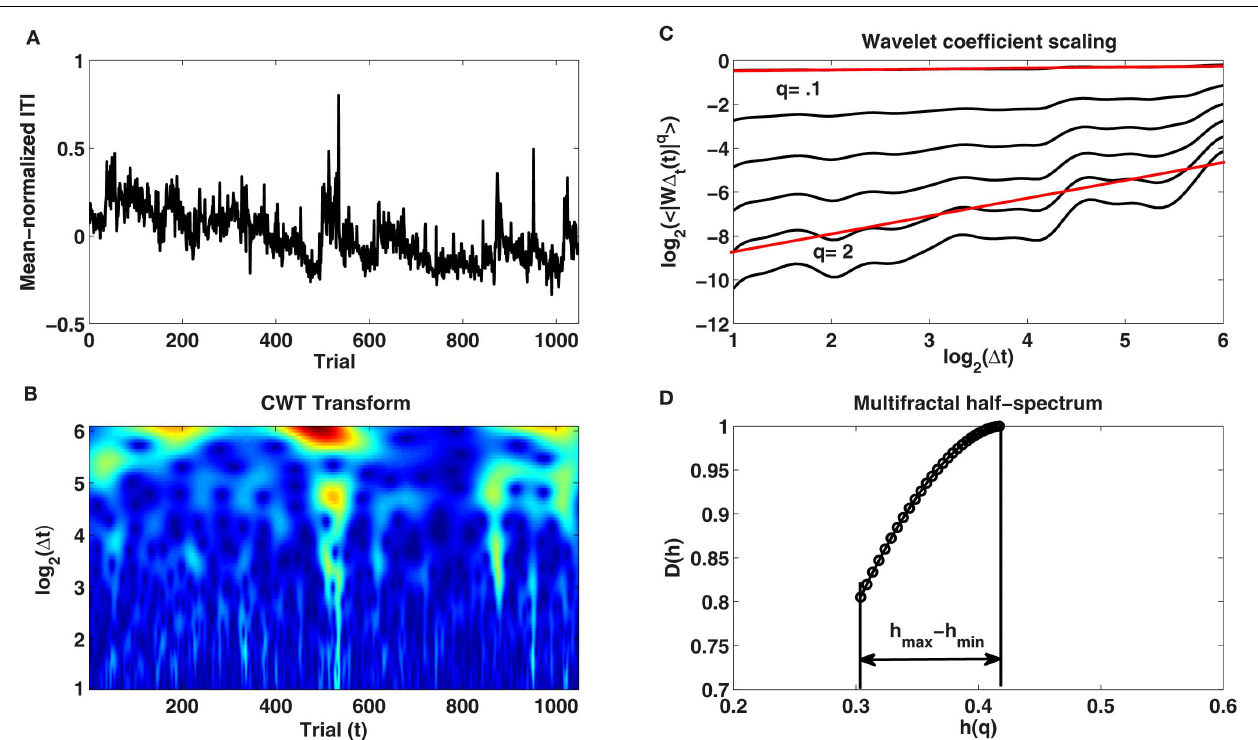
between the averaged absolute wavelet coefficients < | W Δ t ( t )| q > calculated across trials ( t ) at each scale ( Δ t ) and different wavelet scales ( Δ t ) on log–log plot for different q -values (see text). (D) Shows the multifractal spectrum D ( h ) and its width ( h max − h min ) estimated with the